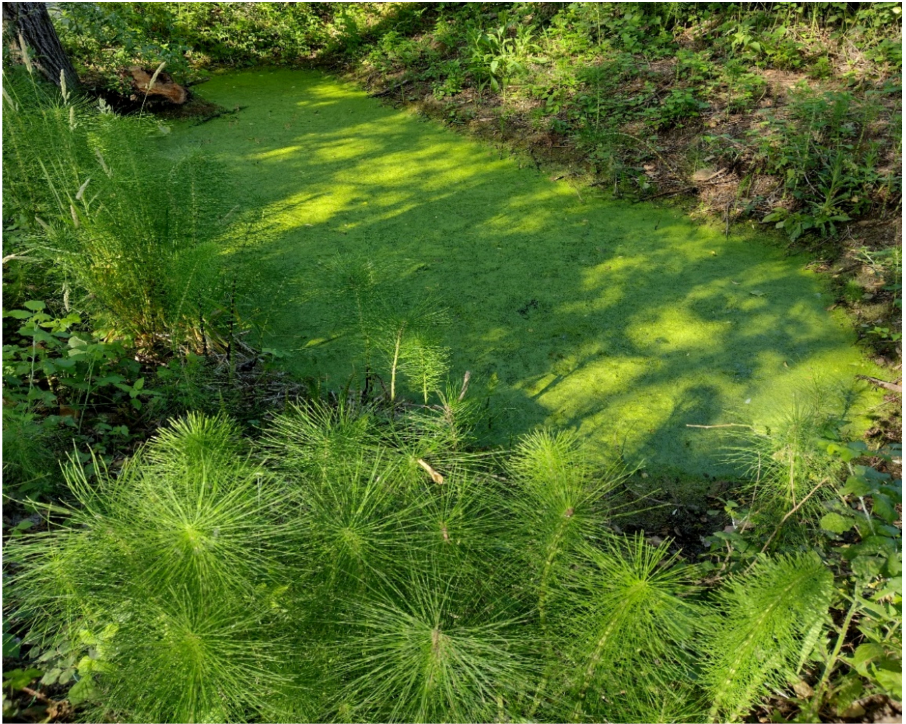
Figure 83. Lemna minuta monophytic community on a pond in Caffarella valley.